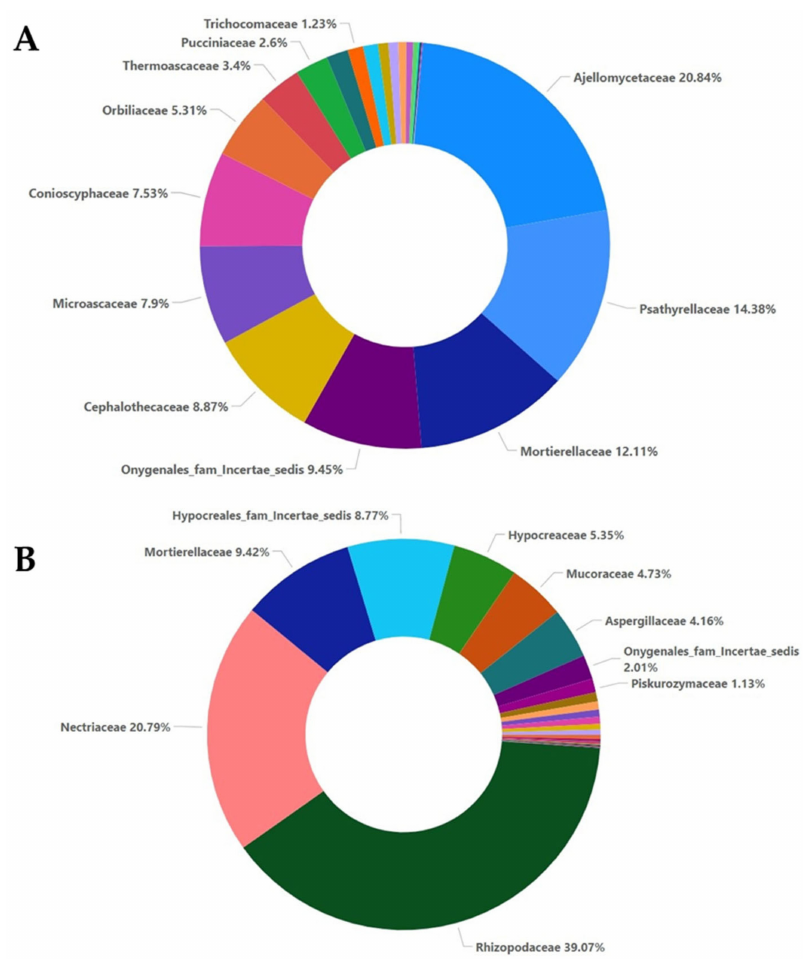
Figure 6. Relative abundance with percentages for the family taxa at a 20% concentration of essential oil for the non-inoculated samples ( A ) and inoculated samples ( B